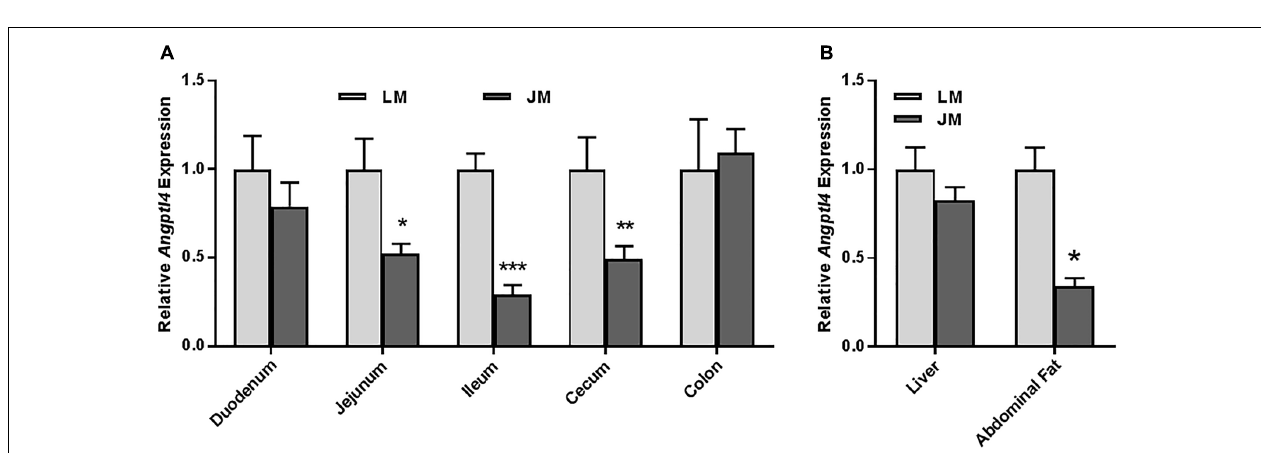
FIGURE 10 | Relative Angptl4 mRNA expression levels in the intestinal tract (A) and the liver and abdominal fat (B) of mouse recipients. The results were shown as means ± SEM of 12 mice. ∗ P < 0.05, ∗∗ P < 0.01, and ∗∗∗ P < 0.001 (by unpaired Student’s t -test). LM, mice receiving fecal microbiota from Landrace pigs; JM, mice receiving fecal microbiota from Jinhua